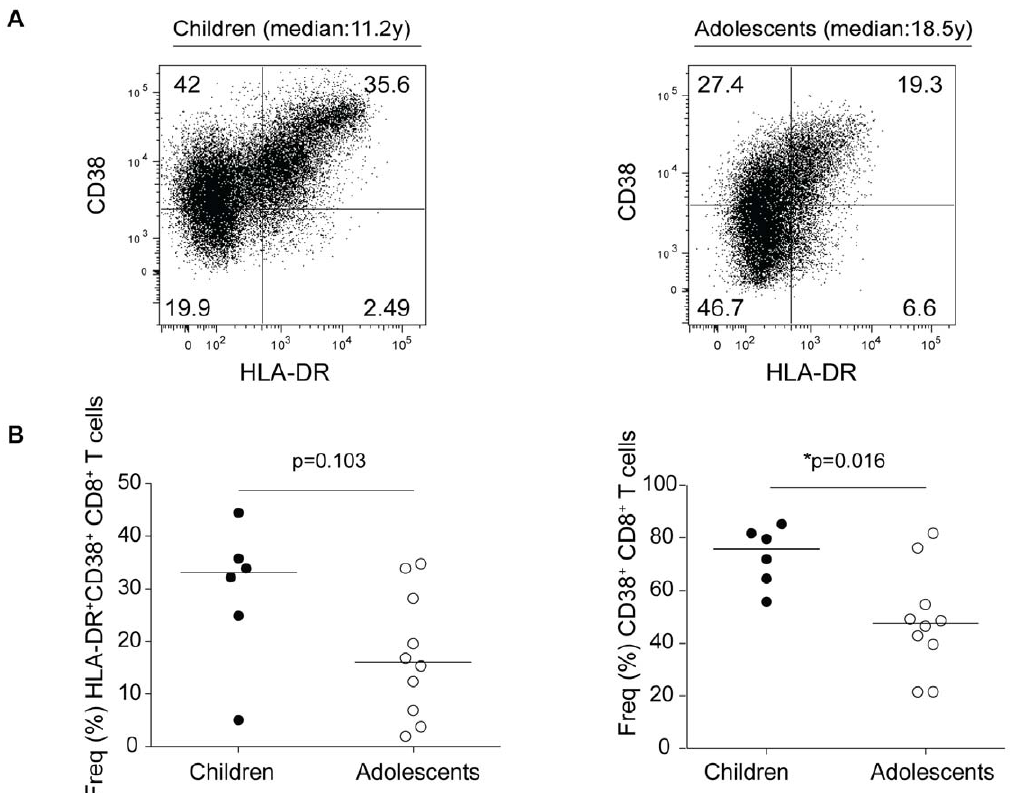
Figure 4. Infection duration and age related decrease in CD8 + T cell activation in adolescents. (A) Flow dot plots show CD8 surface expression of CD38 and HLA-DR in perinatally HIV-1 infected children (median: 11.2 y) and adolescents (median: 18.5 y). Dot plots are representative of all subjects in respective groups. (B) Frequencies of HLA-DR + CD38 + CD8 + T cells and CD38 + CD8 + T cells in perinatally HIV-1-infected children and adolescents. A significant decrease in CD38 + CD8 + T cell (*p=0.016) and a marginal decrease in HLA-DR + CD38 + CD8 + T cell (p=0.103) populations were observed with the duration of HIV infection. P values were obtained using two-tailed Mann-Whitney U test.